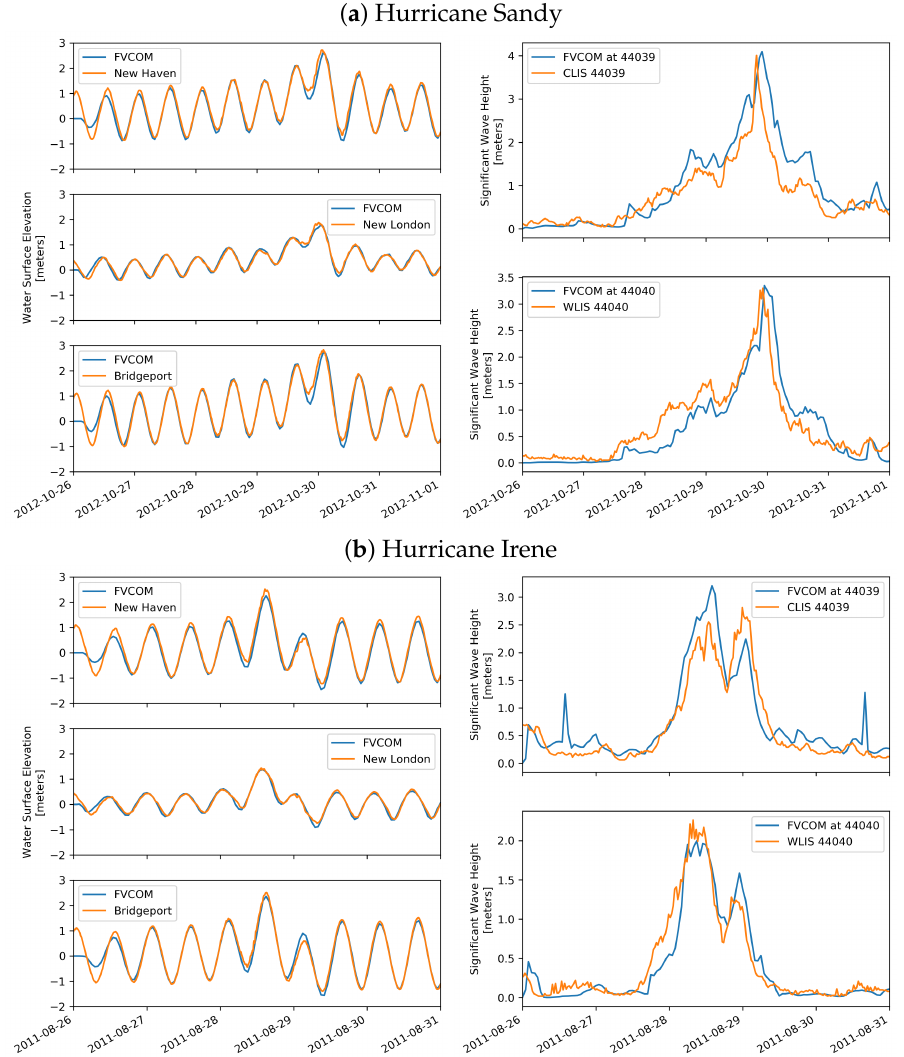
Figure 2. Comparison of water level ( left ) and significant wave height ( right ) time series between model and observation during hurricane Sandy ( a ) and Irene ( b